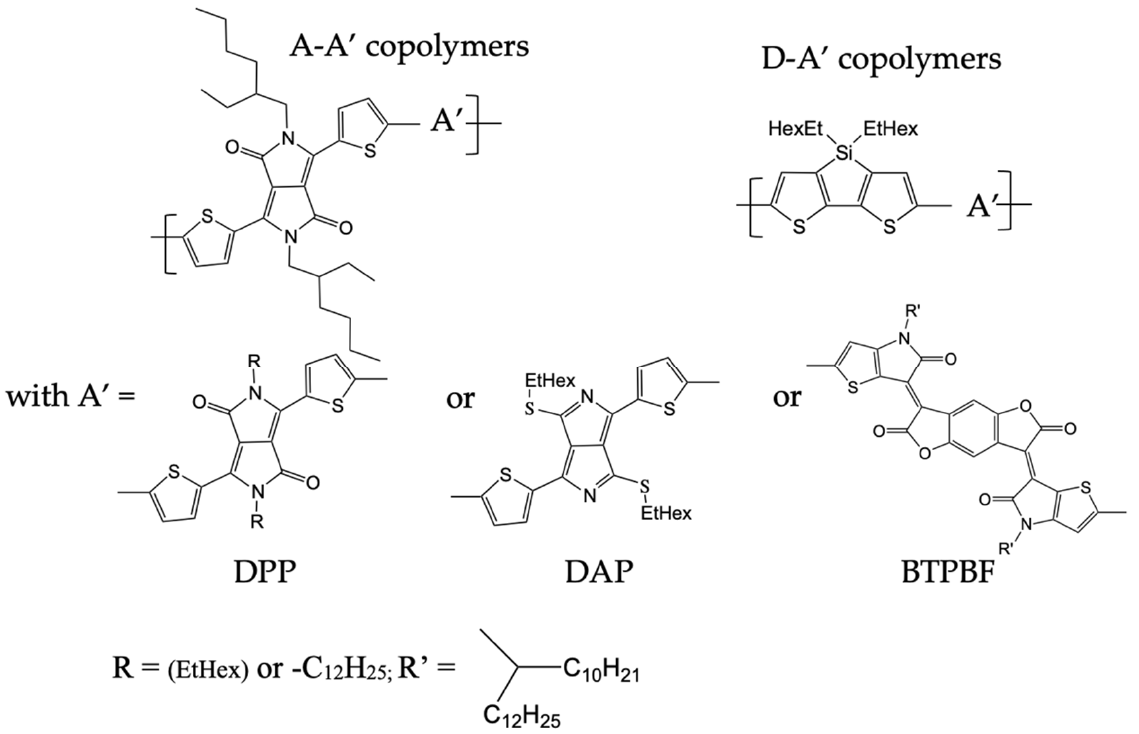
Figure 1. Chemical structures of the A ‐ A’ and D ‐ A’ copolymers considered in this work.